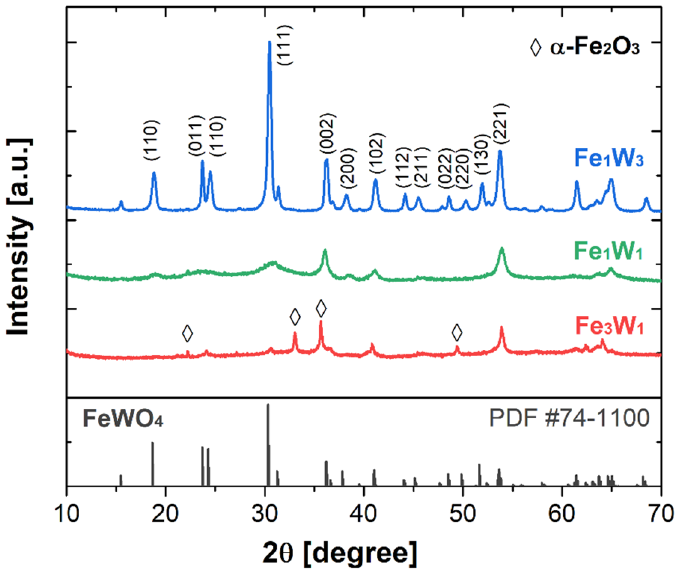
Figure 1. XRD patterns of Fe 1 W 3 (blue line), Fe 1 W 1 (green line), and Fe 3 W 1 (red line). Corresponding pattern for FeWO 4 (JCPDS file no. 74-1100) is given as reference.